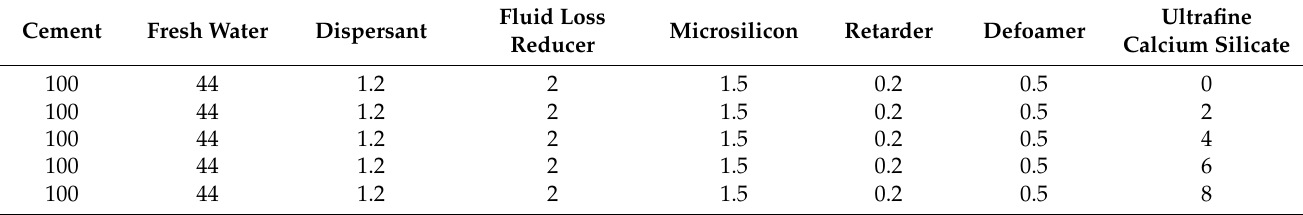
Table 2. The composition of cement slurries. Unit: